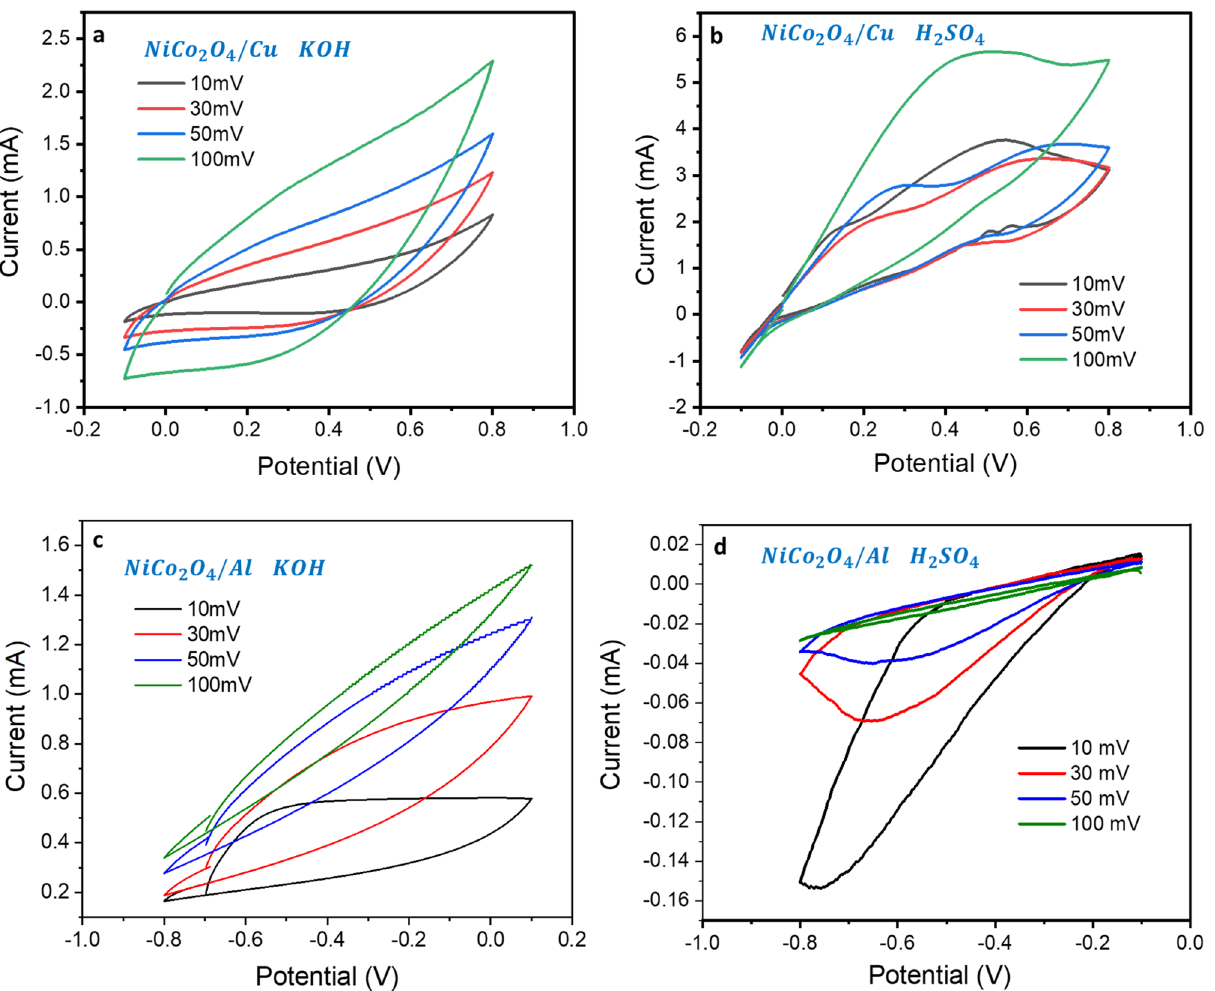
Fig. 6 Cyclic voltammetry of NiCo based device in KOH solution and d Al-based device in H